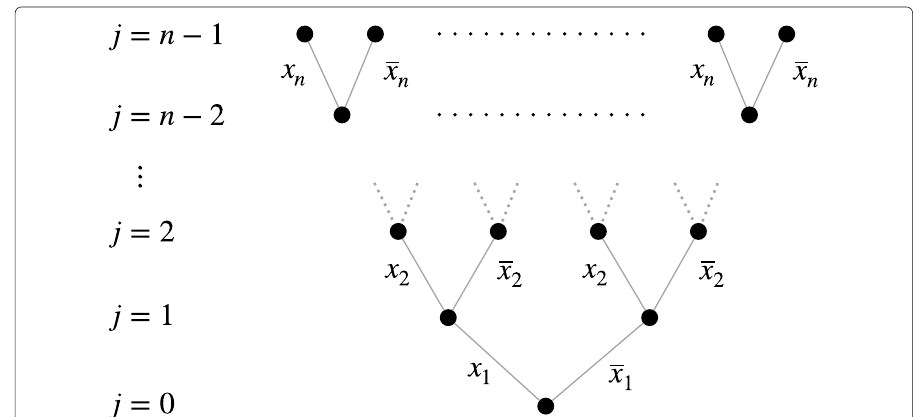
Fig. 2 Tree directed graph of the universal decoder for four variables. Each rank j ( j = 0, ... , n − 1 ) consists of 2 j blocks, and each block realizes 2 ( n − j ) conjunctive terms with j + 1 letters (input